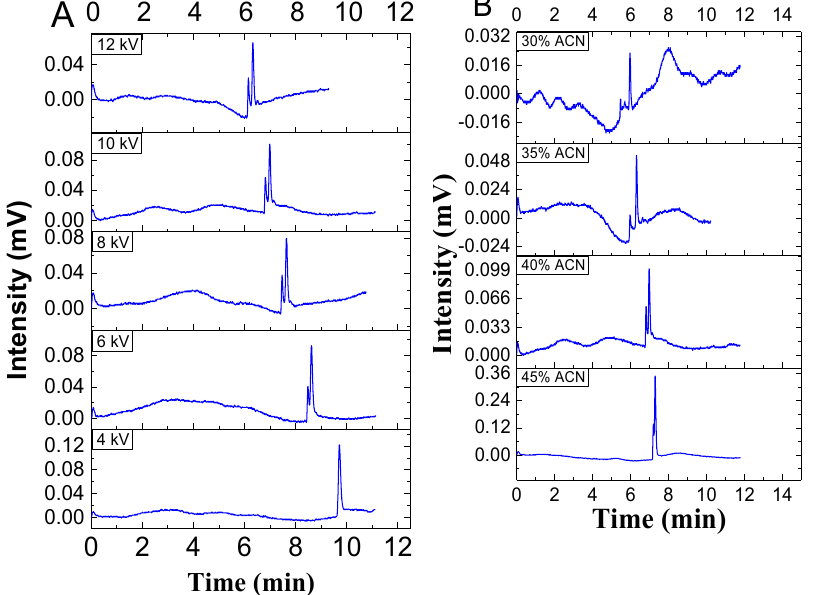
Figure 7. The pCEC separation of ovarian cancer anti ‐ idiotypic mini body and impurity on 300 nm C18 ‐ bonded silica particles. The experimental conditions were as follows: ( A ) column: 100 μ m i.d. × 100/300 mm (effective/total length); mobile phase: acetonitrile–water (40:60, v / v ); 0.1% FA; pH = 2.3; applied voltage = 10, 8, 6, and 4 kV; and pressure = 12.5 MPa; ( B ) column: same as ( A ); mobile phase: acetonitrile–water (30, 35, 40, and 45:60, v / v ); 0.1% FA; pH = 2.3; applied voltage = 10 kV; and pres ‐ sure = 10.5–12.5 MPa.